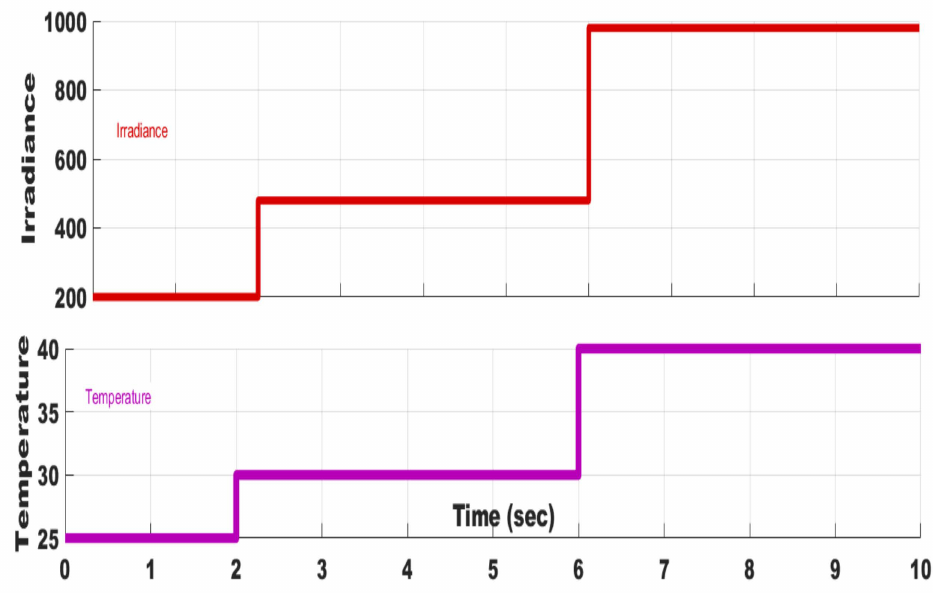
Figure 20. Variable irradiance and temperature response.